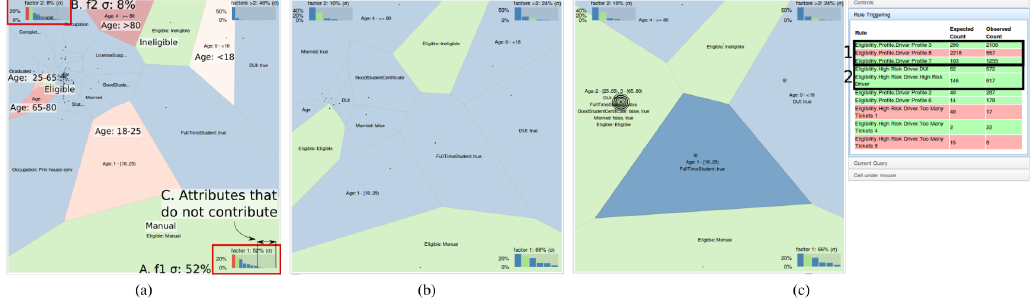
Figure 8. The decision map as an interactive analysis of variables of interest: ( a ) the analysts has selected the complete list of available attributes associated with drivers and then selected the age group bar chart to show where the clusters of age groups sit in the plot; ( b ) the simplified version where all non-contributing variables are removed; and ( c ) a breakdown of the decision process and classification of the “students” demographic. Image courtesy of Broeksema et al. [71].